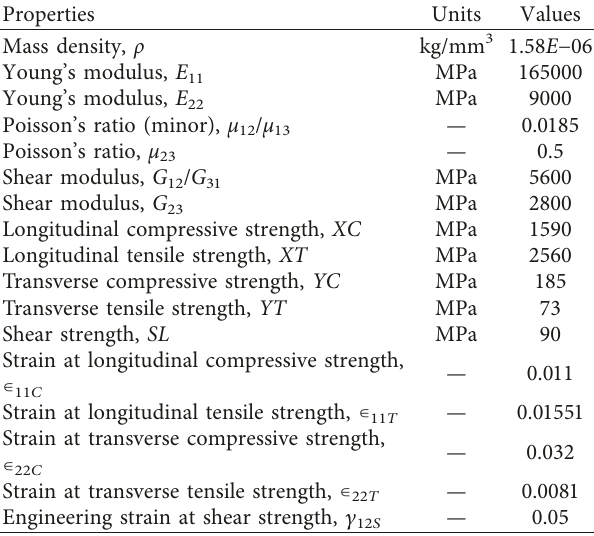
Figure 8: Side test setup. Table 4: Side beam composite material